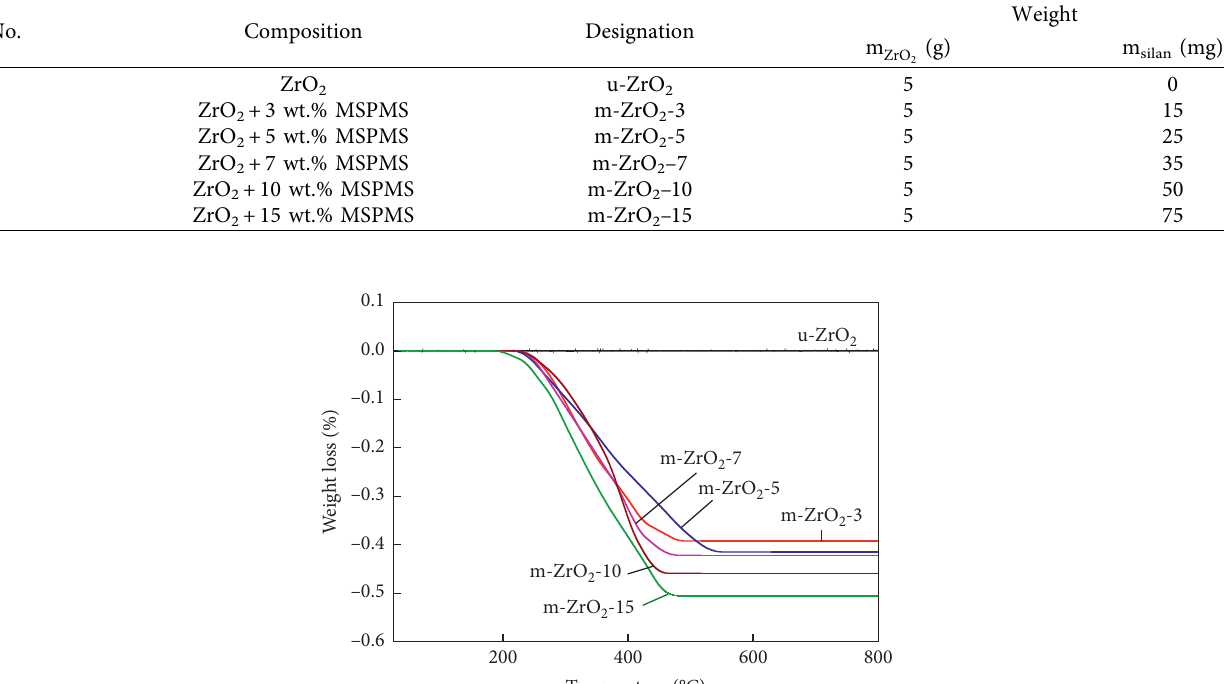
2 nanoparticles.